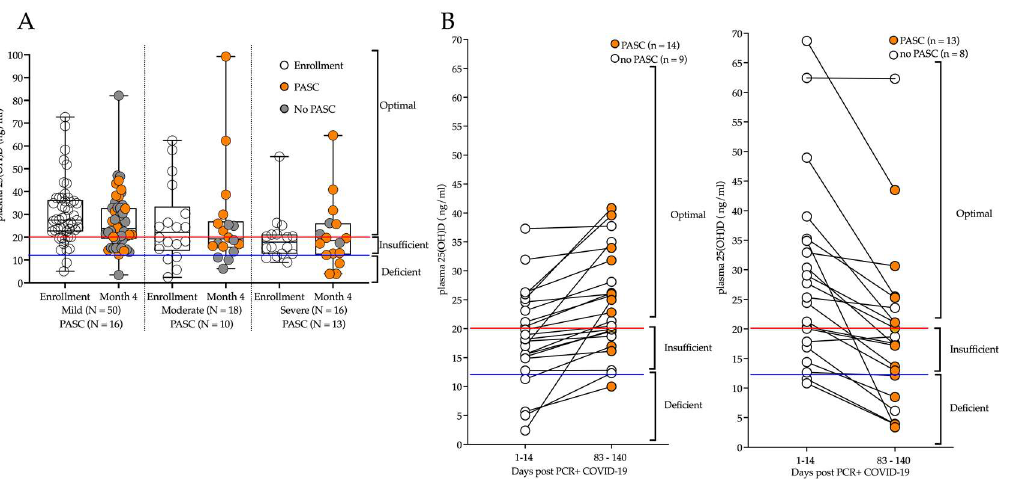
Figure 3. Longitudinal plasma levels of total 25(OH)D for adults diagnosed with COVID-19 at time of enrollment and after 4 months. ( A ) Plasma total 25(OH)D was compared across mild, moderate, and severe COVID-19 disease at time of enrollment; orange circles indicate PASC at month 4. ( B ) Plasma total 25(OH)D for adults enrolled in the acute phase (days 1–14 post PCR+) and at month 4 (day 83–140 post PCR+); Left panel represents participants trending to have an increase in total 25(OH)D from day 1–14 to day 83–140; Right panel shows trending reductions in total 25(OH)D from day 1–14 to day 83–140. For days 83–140, the white circles indicate no PASC, orange circles indicate PASC; below blue line indicates deficient, between blue and red line indicates insufficient, and above red line indicates optimal total 25(OH)D. No statistical significance was detected between the PASC groups or timepoints.